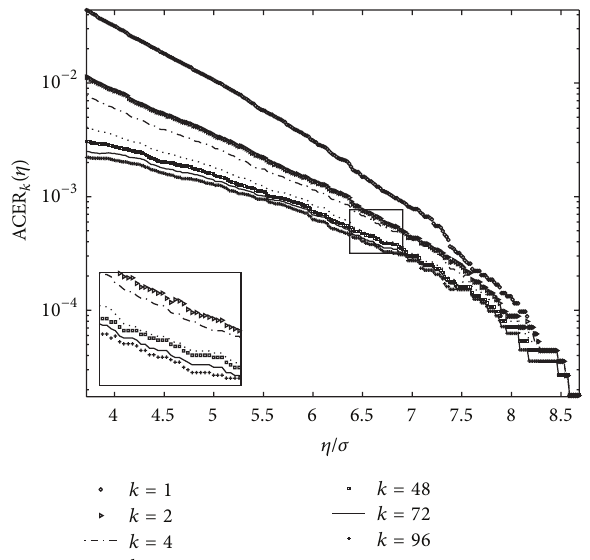
Figure 9: Hekkingen wind speed statistics, 14 years hourly data. Comparison between ACER estimates for different degrees of con- ditioning. 𝜎 = 5.72 m / s.